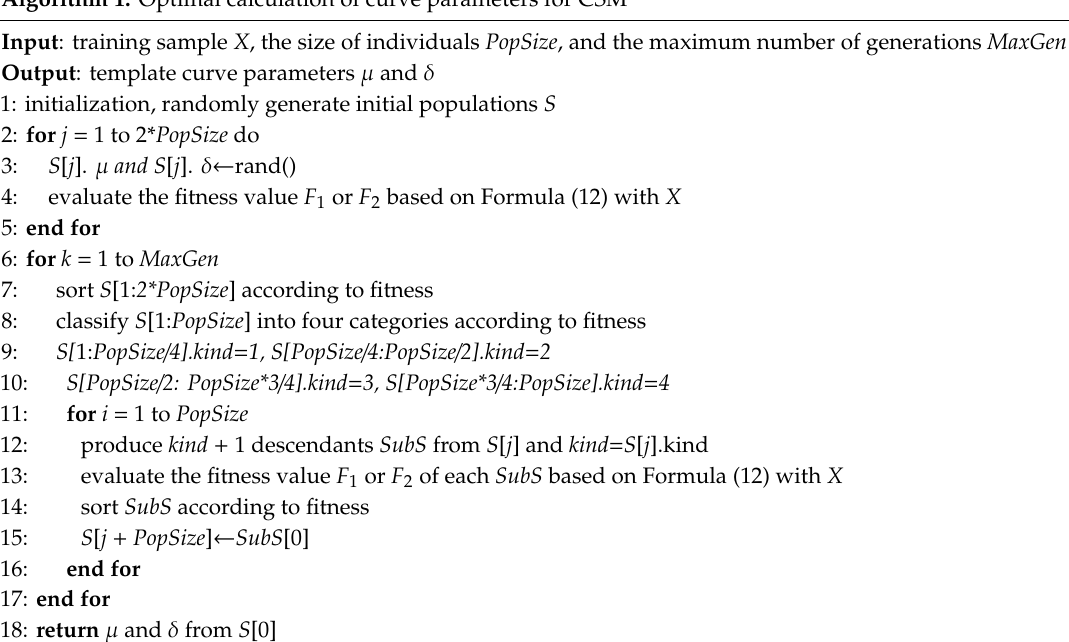
Algorithm 1. Optimal calculation of curve parameters for CSM